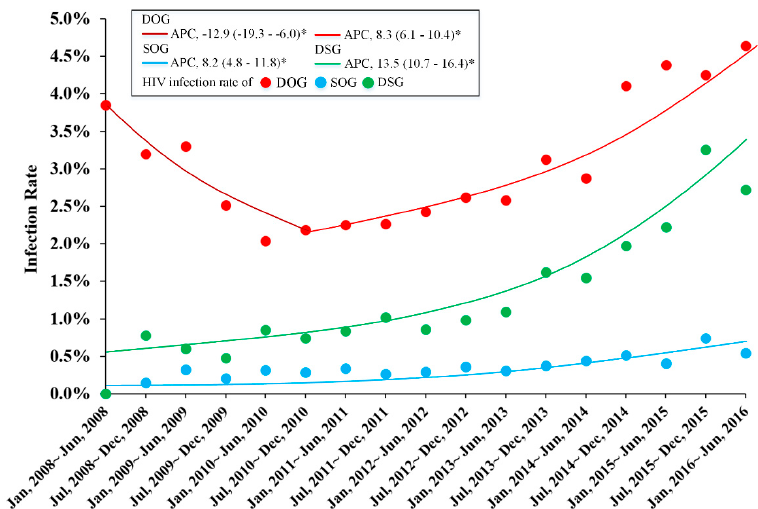
Figure 2. Trends of HIV infection rate among depressants only, stimulants only and both depressants and stimulants users. DOG: depressants users. SOG: stimulants users. DSG: both depressants and stimulants users. * suggested p < 0.05 .